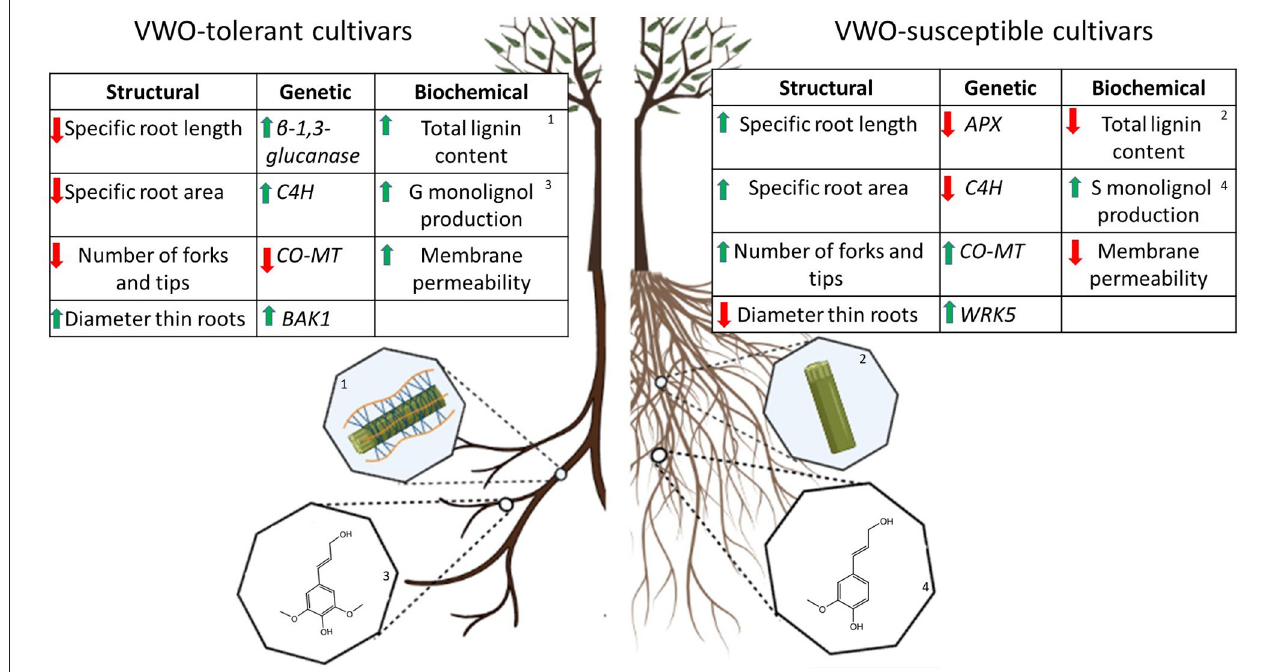
FIGURE 9 | Schematic summary of the major differences related to defense mechanisms found between Verticillium wilt of olive (VWO)-tolerant ( left ) and VWO-susceptible ( right ) olive cultivars at the root level. In the tables, the first column shows the most significant differences found in the root system architecture, in the absence of the pathogen. The second and third columns report the differences observed at the genetic and biochemical levels, respectively, after Verticillium dahliae inoculation. Increases are shown by green arrows, while decreases are represented by red arrows. The 1 high or 2 low content of lignin in the roots are represented by the major quantity or absence of the lignin polymers (blue lines) in the lignocellulose structure (green rectangle), respectively. 3 High G monolignol content in the roots is represented by the chemical structure of coniferyl alcohol, while 4 high S monolignol presence is represented by the chemical structure of sinapyl (S)